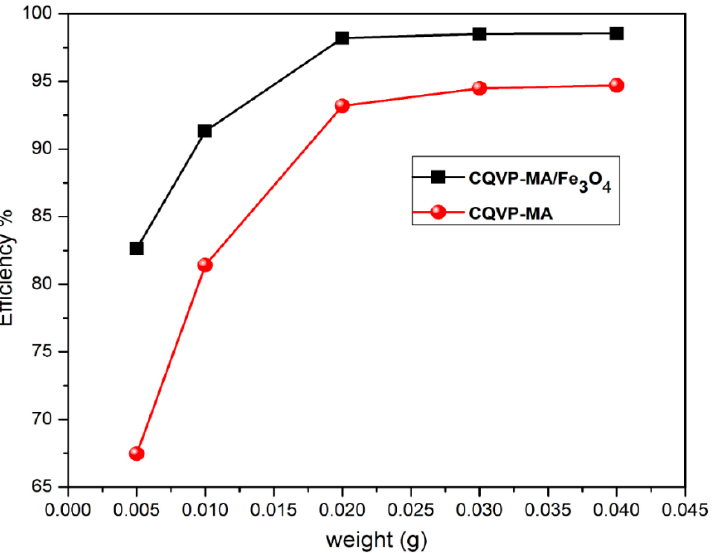
Figure 9. The effect of adsorbent dosage on the adsorption efficiency of CBB dye from aqueous so- lutions at ambient temperature. solutions at ambient